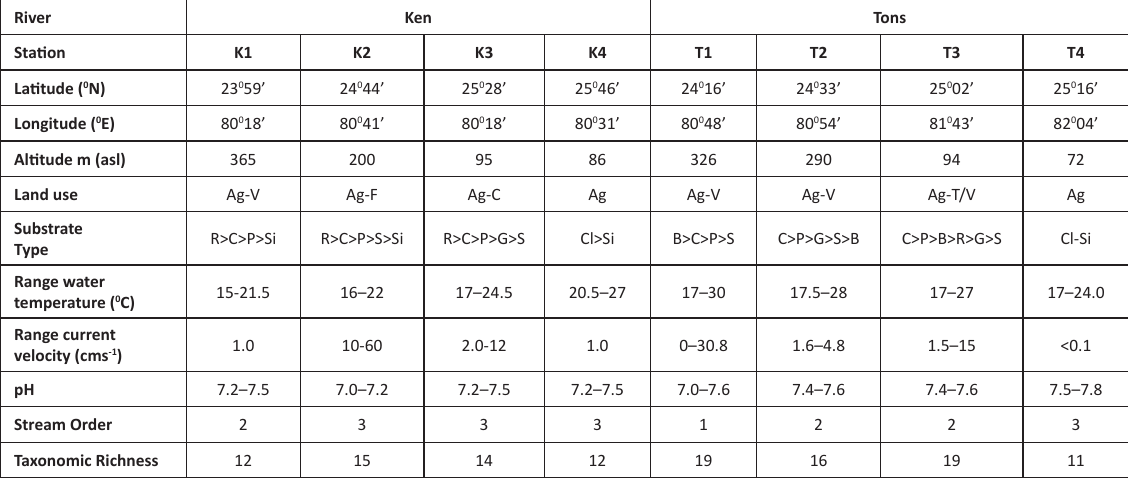
Table 1. Geographical coordinates of the sampling locations along with physico-chemical characteristics, landuse, and taxonomic richness. River